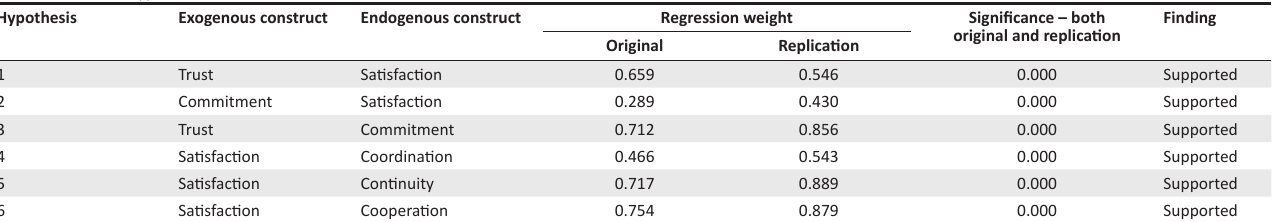
TABLE 7: Tests of hypotheses.